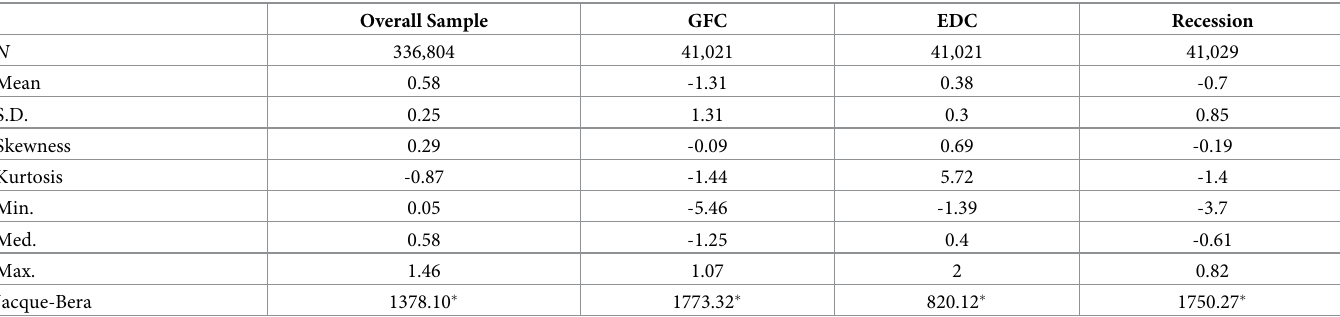
Table 2. Descriptive statistics of monthly returns and Sharpe ratios for US mutual funds.